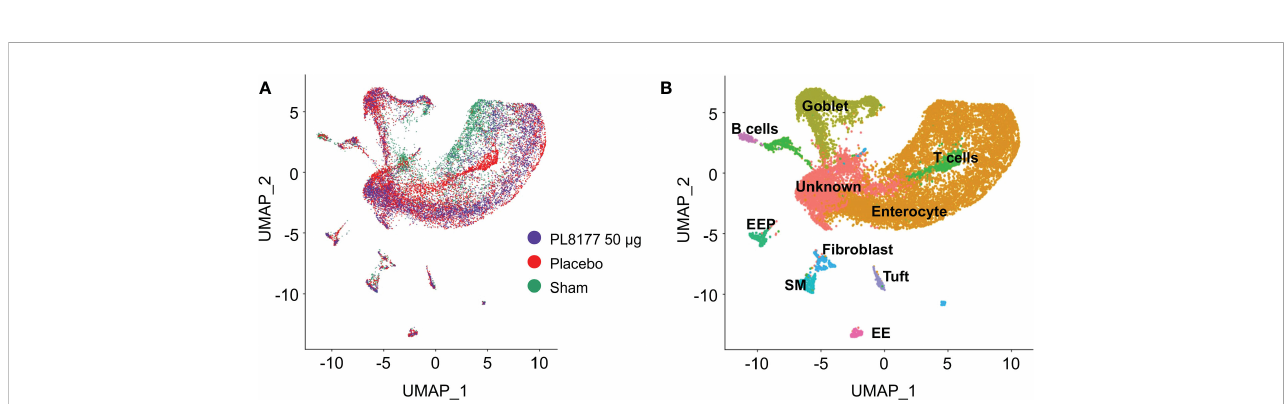
FIGURE 7 Single nuclei RNA-seq analysis reveals cellular composition of DSS colitis – induced rat colon tissue in sham, placebo, and PL8177 50 µg samples. (A) UMAP plots display cell-type clusters derived from all the treatment groups. Each dot represents a cell. Cells in PL8177 50 µg samples are shown in violet, placebo in red, and sham in green. (B) UMAP visualization of cells after annotating cell clusters. Expression of cell-type marker genes was used to annotate each cluster. Colors of the dots represent the cluster to which the cells belong. DSS, dextran sulfate sodium; EE; enteroendocrine; EEP, enteroendocrine progenitor; SM, smooth muscle; UMAP, Uniform Manifold Approximation and